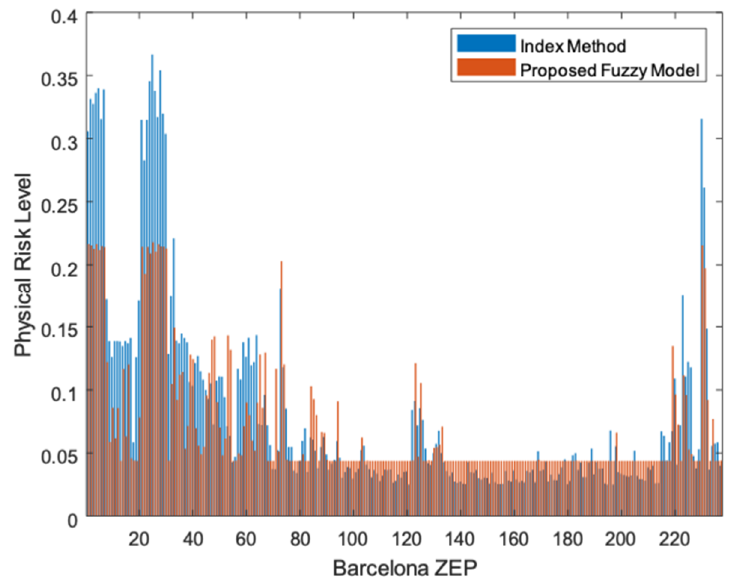
Figure 6. Physical Risk values for the 248 Barcelona small statistical areas (ZEP).